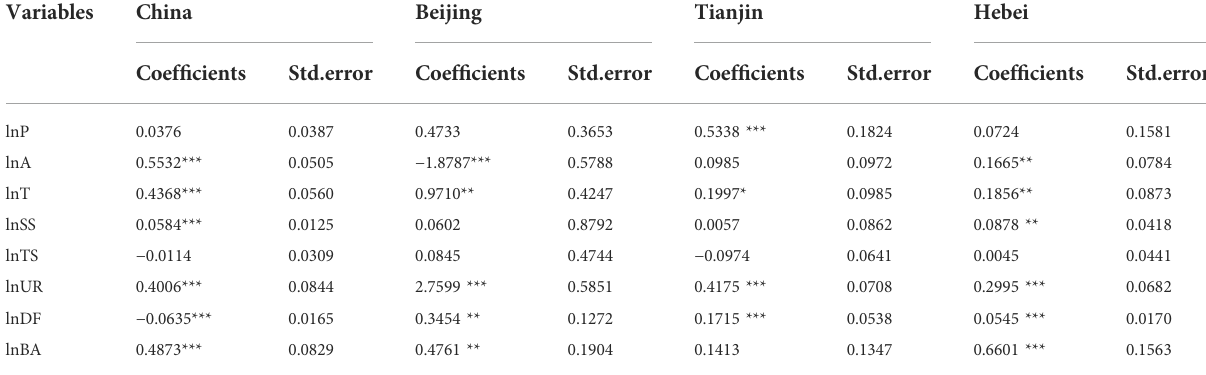
TABLE 4 PLS regression results of STIRPAT model.